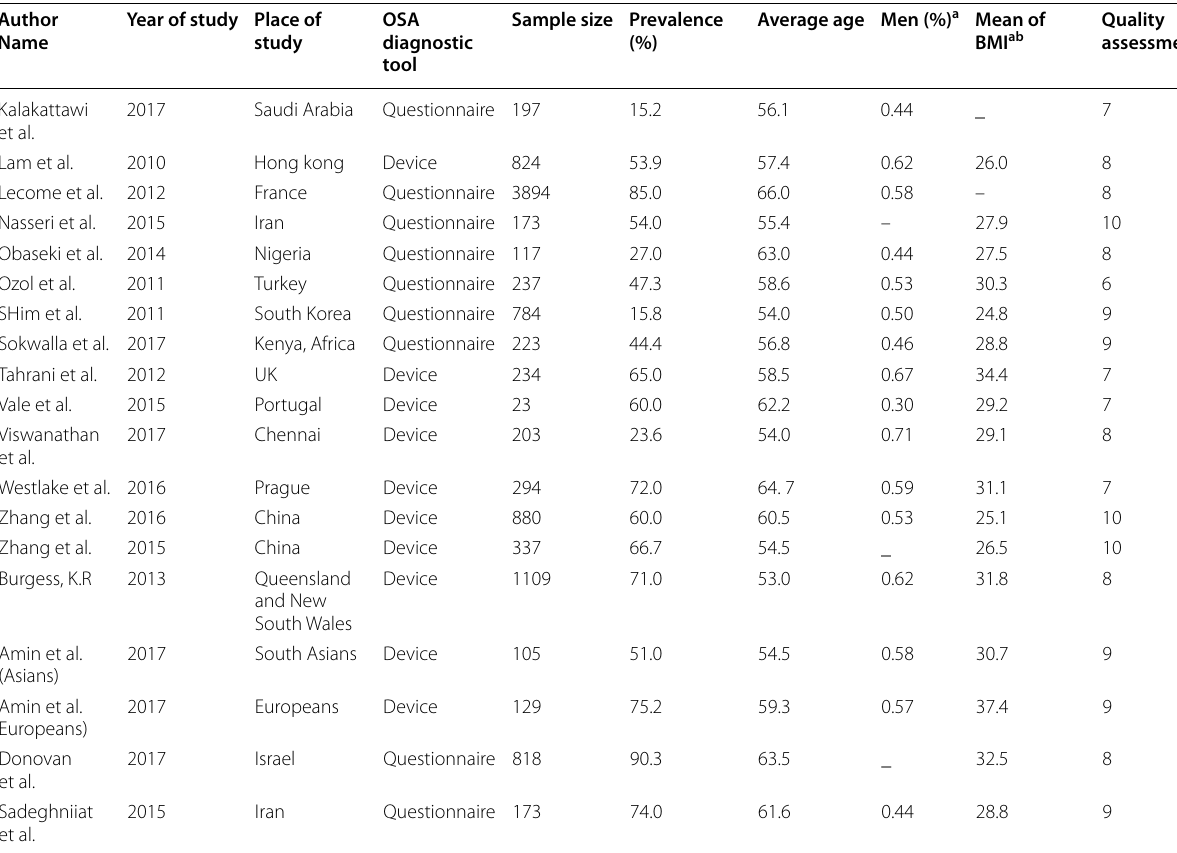
Table 1 Specifications of the included